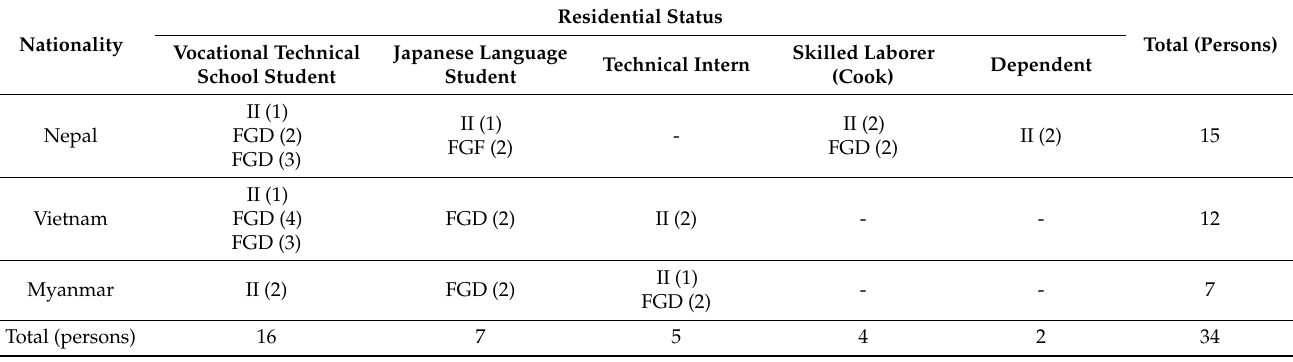
Table A1. Breakdown of participants by nationality and residential status.